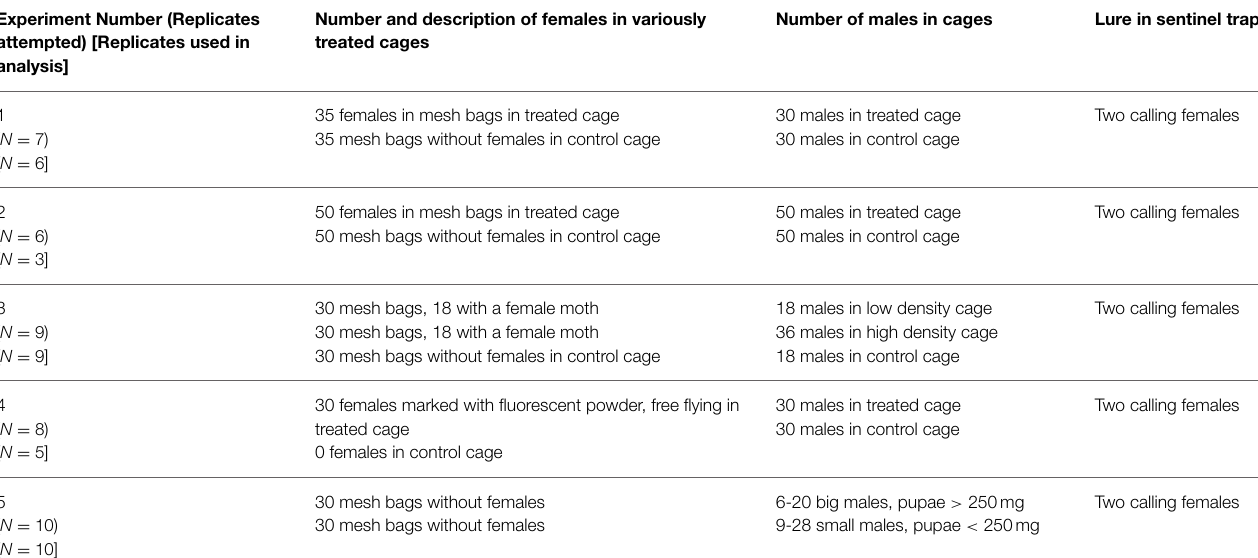
TABLE 1 | Experimental design of treatment and control field cages in experiments 1-5, conducted in 2008 and 2009. Experiment Number (Replicates attempted) [Replicates used in